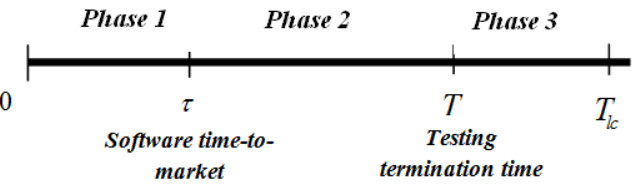
Figure 1. Different phases of failure occurrence